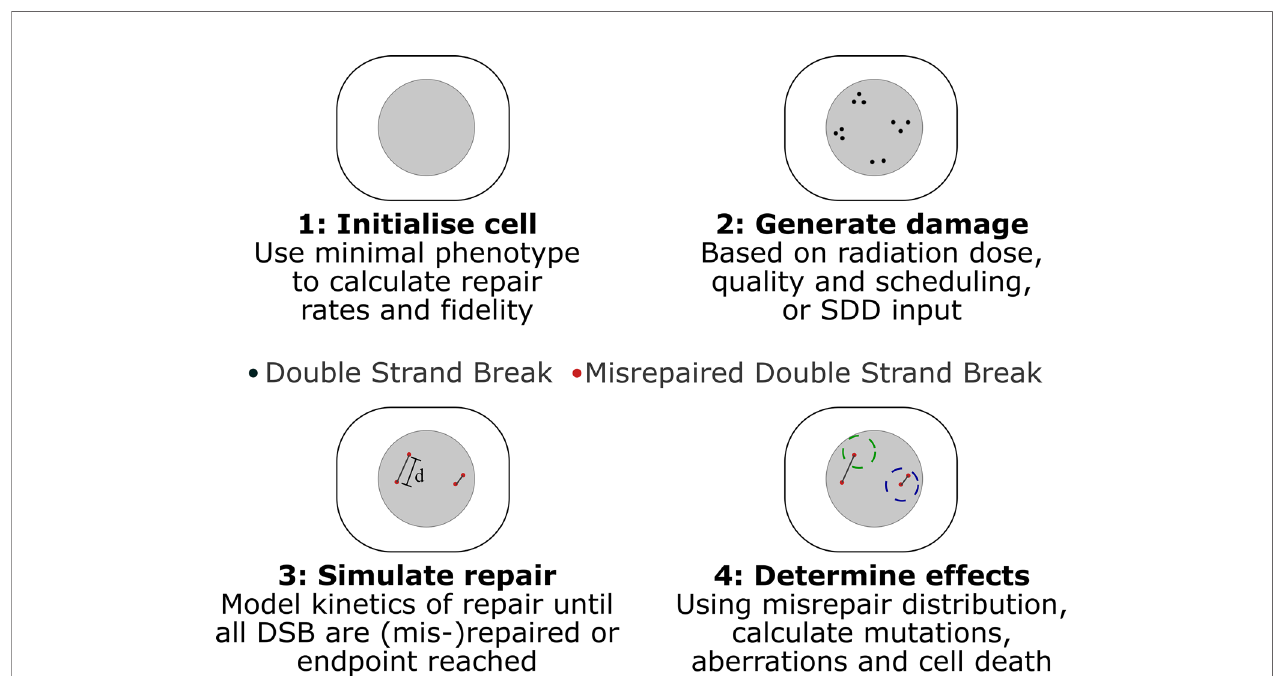
FIGURE 1 | Schematic of key stages in Medras simulation of damage. 1) Cells are initialized, based on provided characteristics, determining rates and fi delity of repair. 2) Damage patterns are generated, either in Medras based on a described exposure or a provided SDD input fi le, incorporating details of track structure as relevant. 3) Repair is simulated as a function of time, tracking both amount of repair and distribution of misrepaired DSBs, with misrepair probability governed by inter-break separation d. Interacting breaks indicated by grey lines. 4) Biological endpoints are quanti fi ed. This can include number of unrepaired and misrepaired DSBs, but also mutations and chromosome aberrations, taking into account a simpli fi ed chromosome model, where spherical territories (dashed circles) are modelled to identify inter-chromosome (left) and intra-chromosome (right)